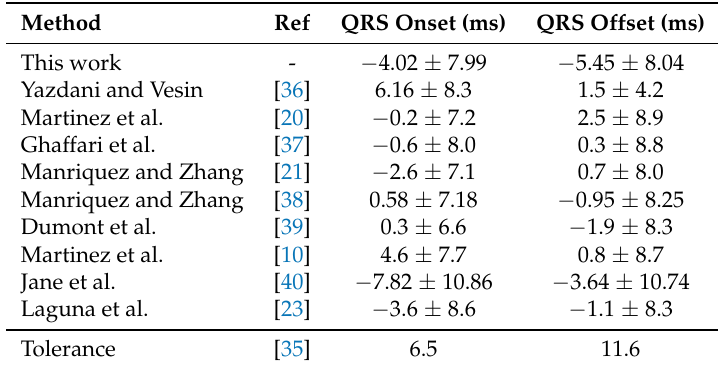
Table 1. QRS segmentation performance comparison in the QT-DB.